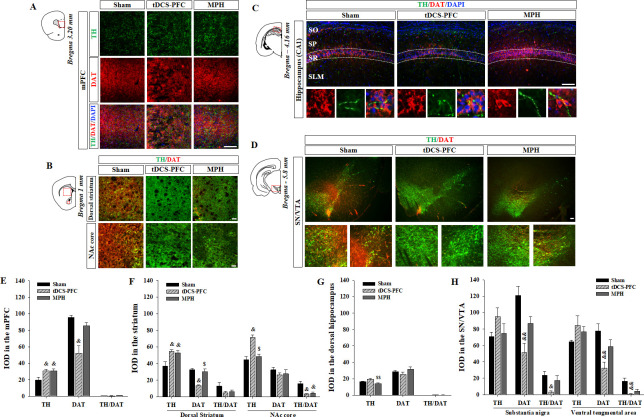
Effect of HD-tDCS application over the prefrontal cortex on TH- and DAT-positive cells in a rat model of ADHD.(A, E) Photomicrograph and histogram showing the mean IOD of TH- and DAT-positive cells in the medial prefrontal cortex, (B, F) in the striatum, (C, G) in the dorsal hippocampus, and (D, H) in the SN/VTA. The IOD of TH-positive cells was significantly increased in the medial prefrontal cortex and striatum of tDCS-PFC group compared to the sham results. The IOD of DAT-positive cells was significantly decreased in the medial prefrontal cortex, dorsal striatum, and SN/VTA in the tDCS-PFC group compared to the sham results. Data are presented as the mean ± SEM. mPFC, medial prefrontal cortex. &p<0.05 and &&p<0.01 vs. sham, $p<0.05 and $$p<0.01 vs. tDCS-PFC. Scale bar = 100 µm.Figure 3—source data 1.Source file for quantification of Iba1-, TH-, and DAT-positive cells.This zip archive contains all source data for Iba1-, TH-, and DAT-positive cells analysis shown in Figure 3, and Figure 3—figure supplements 1 and 2.